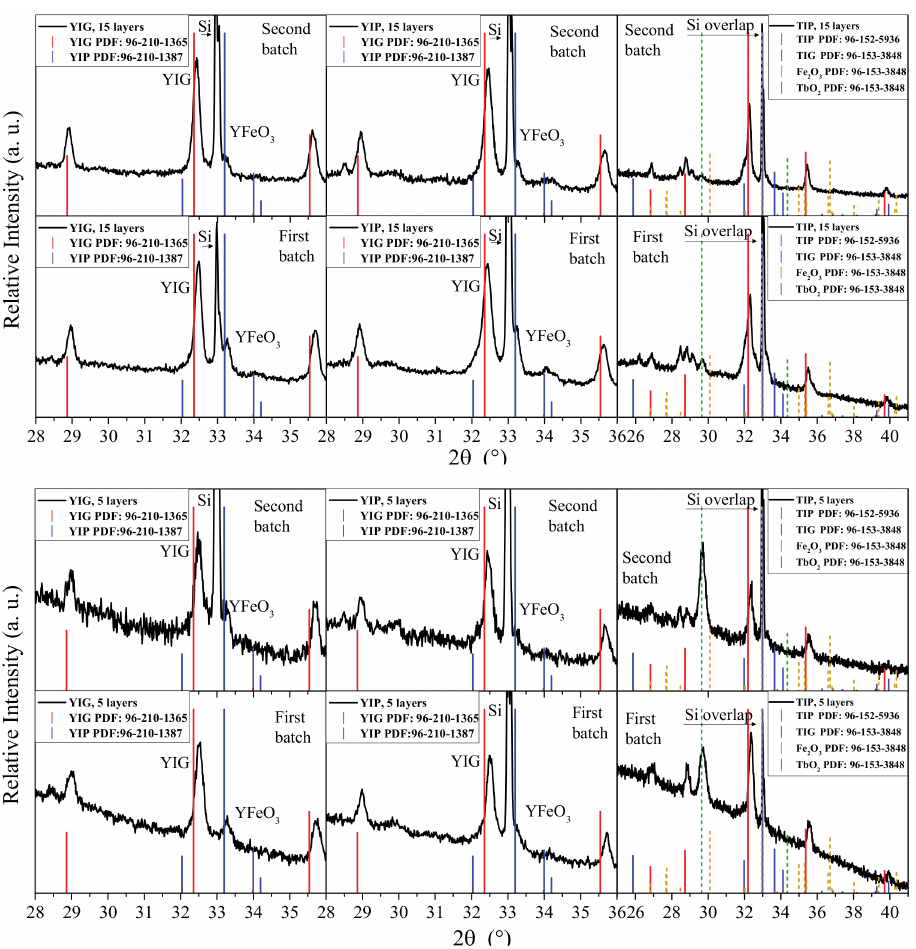
Figure 3. XRD patterns of 5-layer ( bottom patterns) and 15-layer ( top patterns) YIG, YIP, and TIP coatings obtained by sol-gel method using a dip-coating procedure. “First batch” indicates the initial experiment, while “Second batch” indicates the repeated